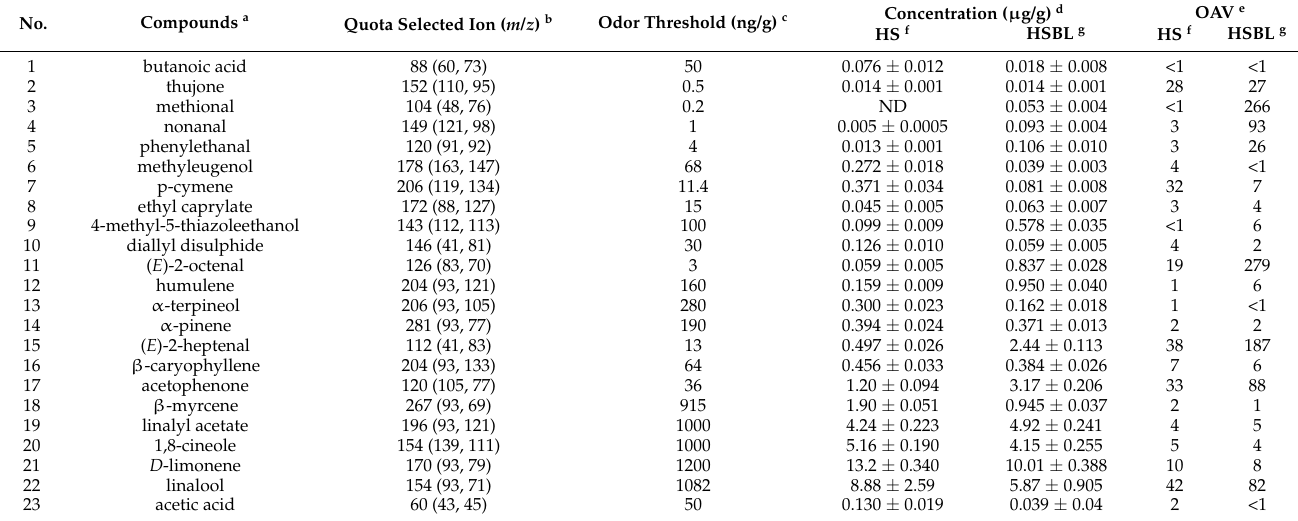
Table 2. Concentrations, odor thresholds, and OAV of key aroma-active compounds in hotpot seasoning before and after boiling.